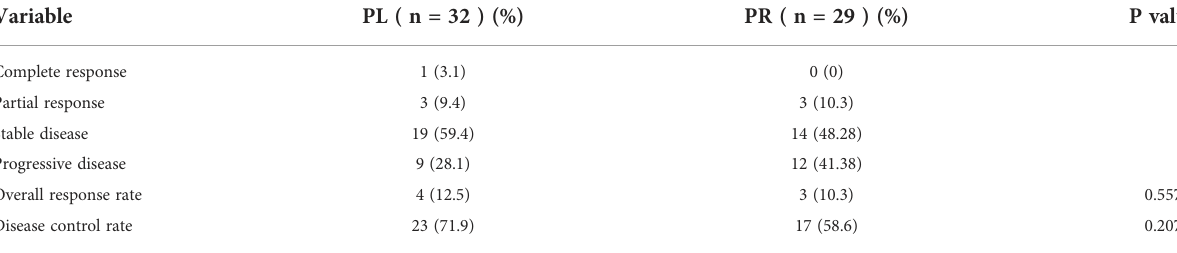
TABLE 3 Response to treatment according to RECIST ver.